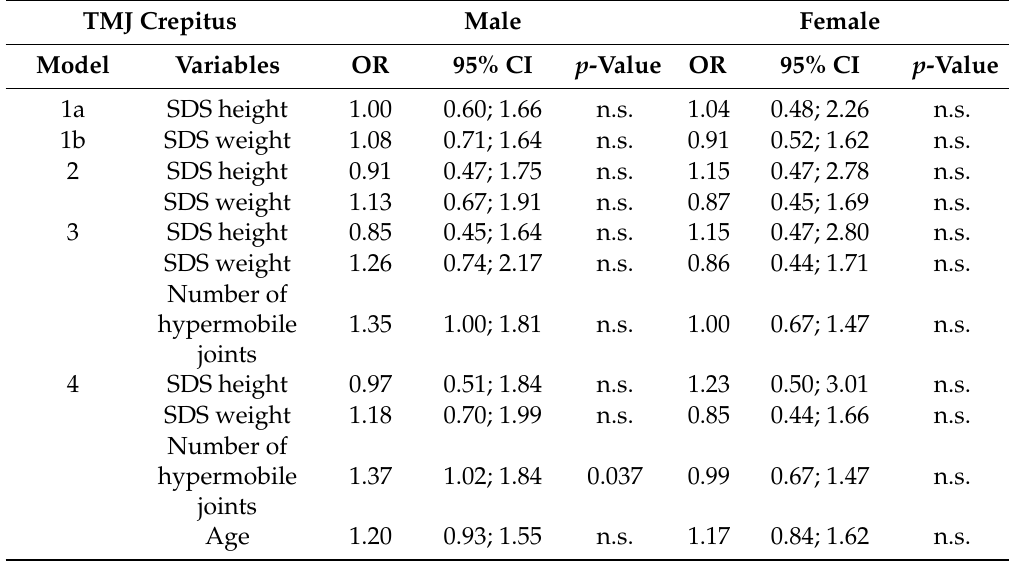
Table 5. Multivariable analyses of TMJ crepitus (N = 20) in relation to physical variables; SDS: standard deviation scores, OR: odds ratio, CI: confidence interval, n.s.: not